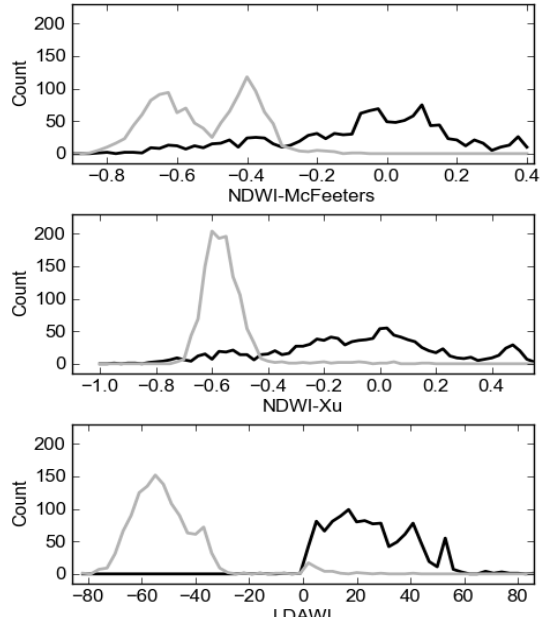
Figure 5. Histograms of water index values for the 2,400 validation points, separated into water (black line) and non-water (grey line), for the normalized difference water index of McFeeters (NDWI ) and Xu (NDWI ), and the linear discriminant analysis water McFeeters Xu index